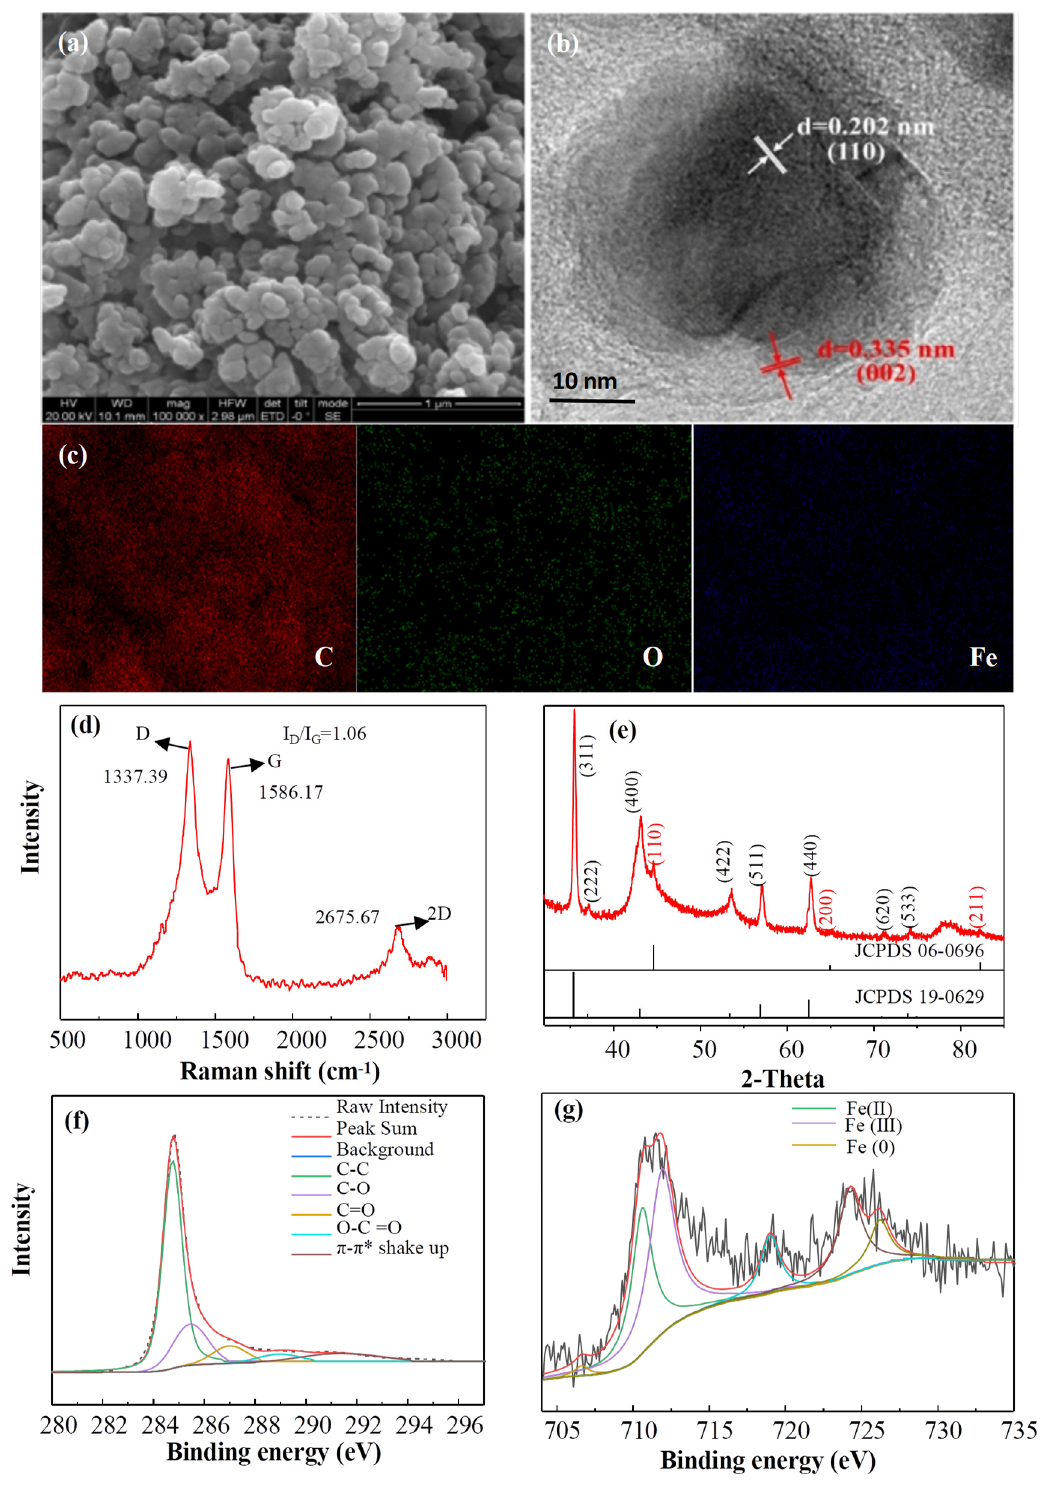
Figure 4. SEM ( a ), TEM ( b ), Elemental mapping ( c ), Raman spectrum ( d ), XRD pattern ( e ), C 1 s XPS spectrum ( f ) and Fe 2p XPS spectrum ( g ) images of the Fe@MC.